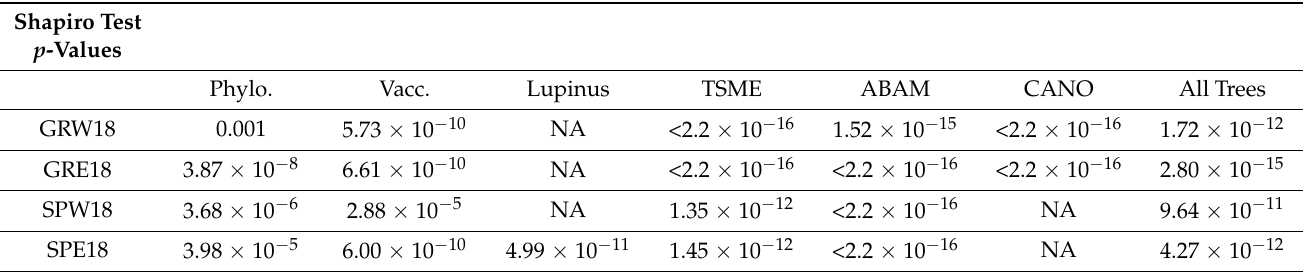
Table A3. Shows consistently significant p -values for the Fligner-Killeen test, which indicates that data is not homoscedastic. Fligner Test p -Values Phylo. All